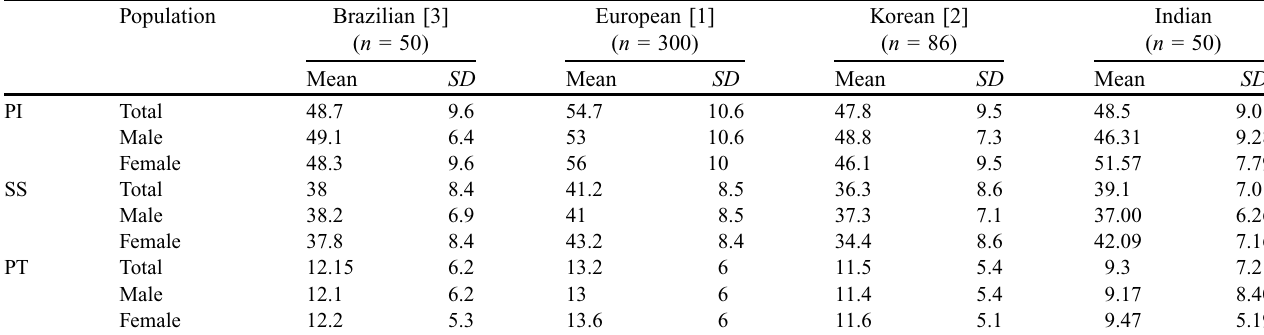
Table 5. Comparison of different populations.